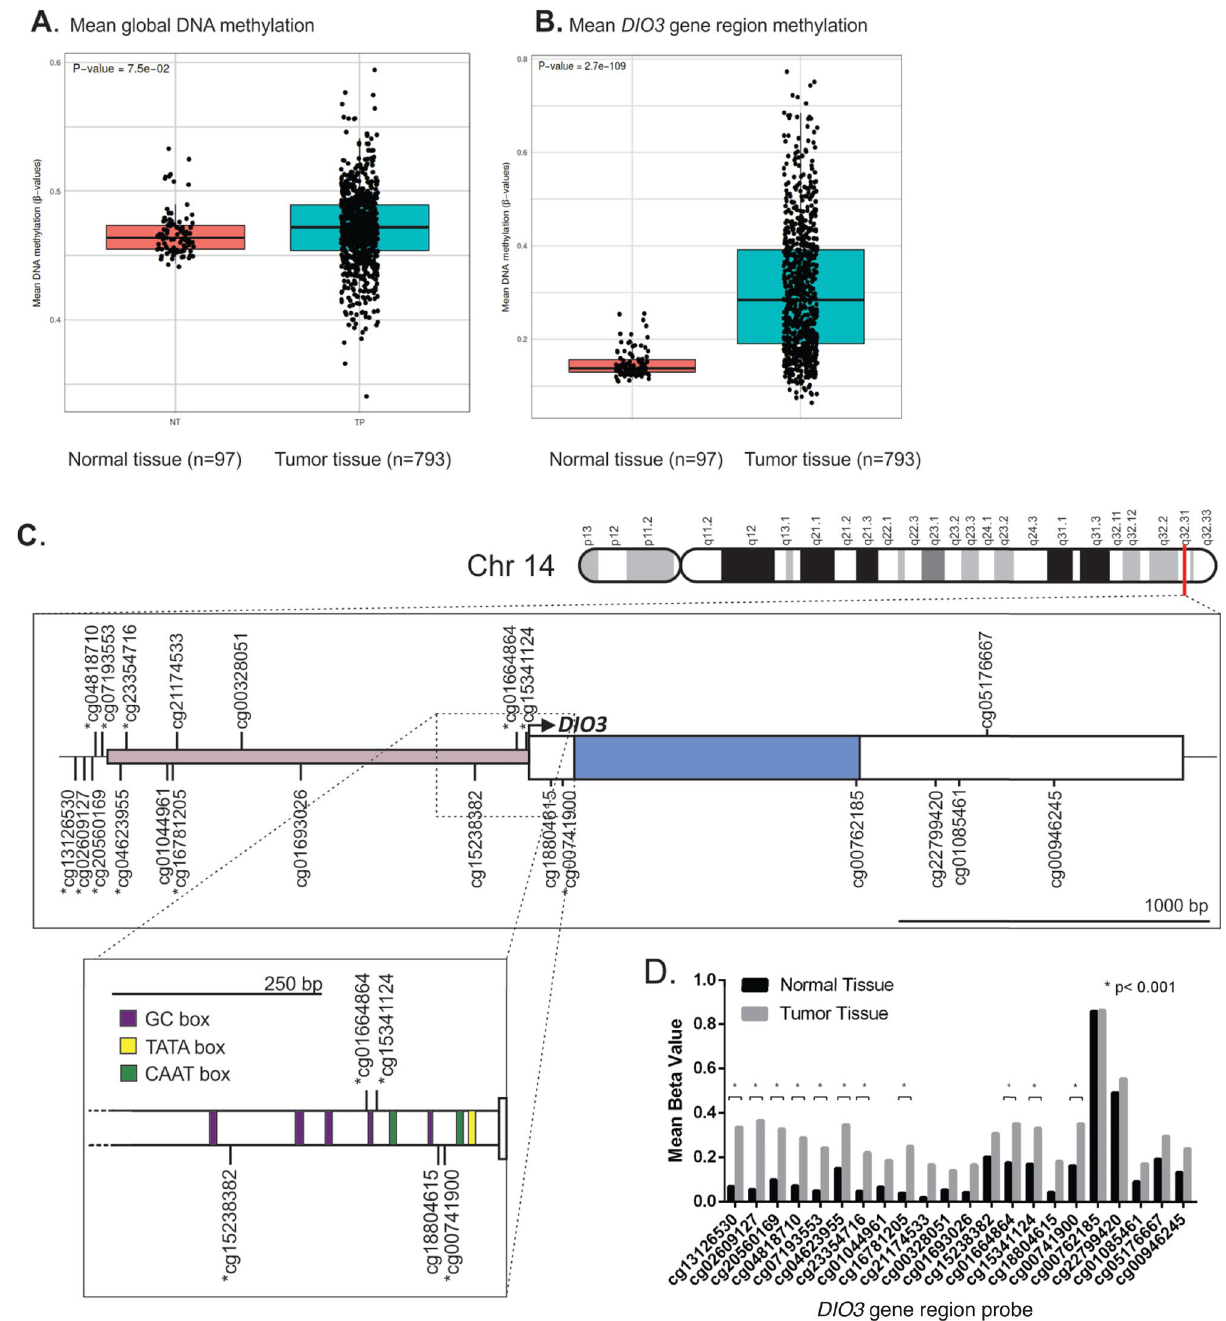
Figure 5. Panel ( A ) demonstrates mean global DNA methylation levels (β-values) in breast cancer tissue compared to healthy breast tissue. Panel ( B ) demonstrates that the mean DNA methylation of DIO3 gene region is increased in tumor tissue when compared to normal tissue ( P < 0.001). Panel ( C ) is a schematic representation of the location of DIO3 gene in chromosome 13 and the regions that were evaluated by CpG probes. The promoter region is composed by several promoter elements including a TATA box, two CAAT boxes and CG rich regions ( C , enhanced). Significant hypermethylation in several CpG sites (*) is observed in the promoter region of the gene. Panel ( D ) presents mean β-values of CpG sites mapped in DIO3 gene region comparing normal and tumoral